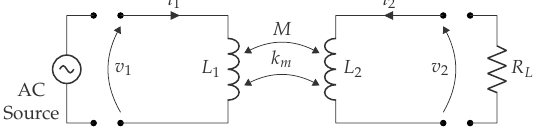
Figure 4. Basic circuit of an inductively coupled WPT